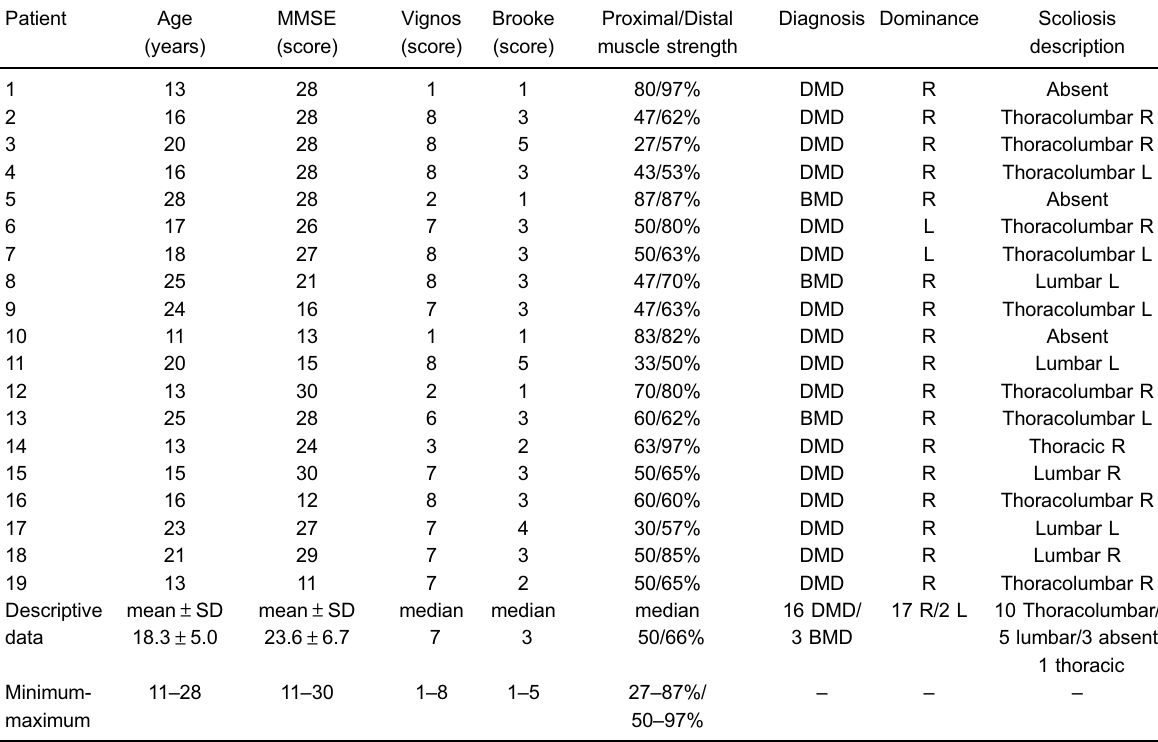
Table 1 . Characteristics of study